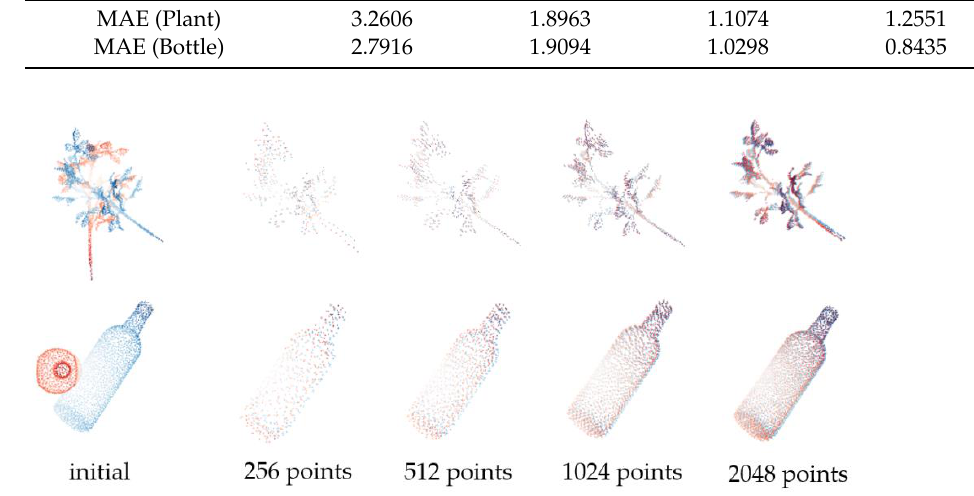
Figure 3. Registration results from sparse to dense sampling.